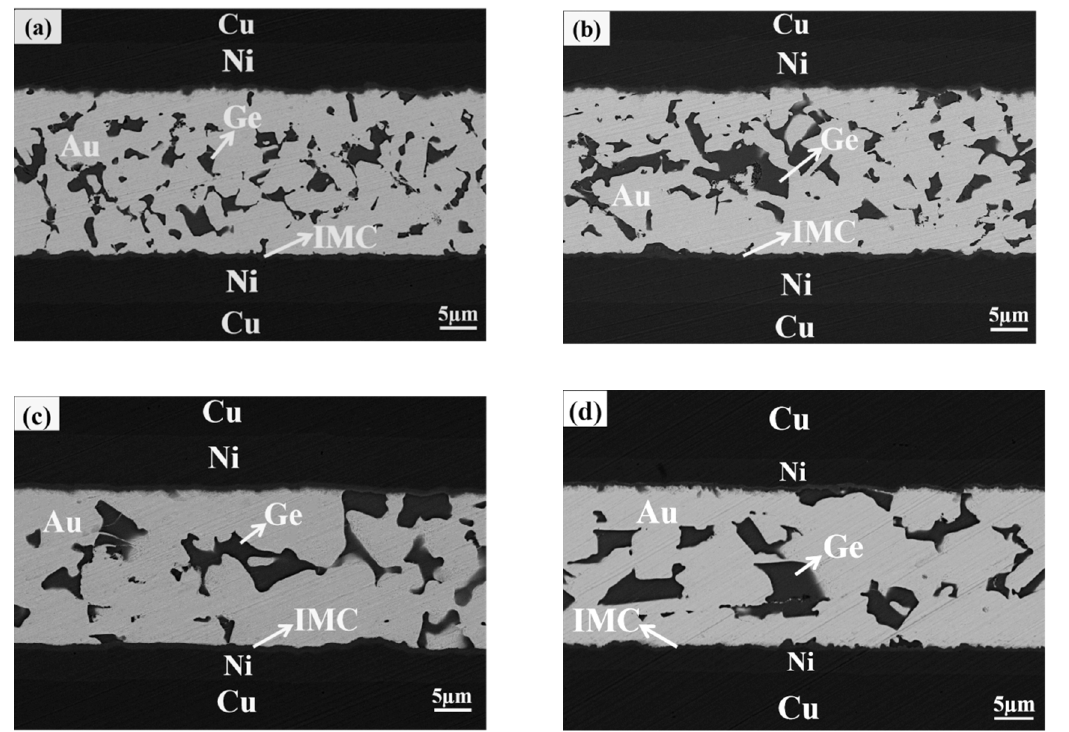
Figure 7. SEM micrograph of Cu / Ni / Au / Au-12Ge / Au / Ni / Cu solder joints: ( a ) 100 cycles; ( b ) 200 cycles; ( c ) 300 cycles; ( d ) 400 cycles.